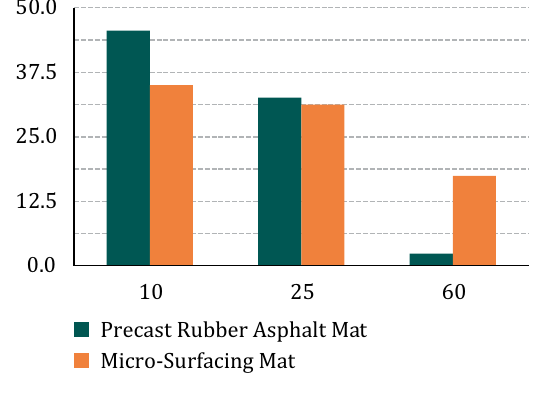
b) shear Figure 10. Shear stress and stiffness under various temperatures